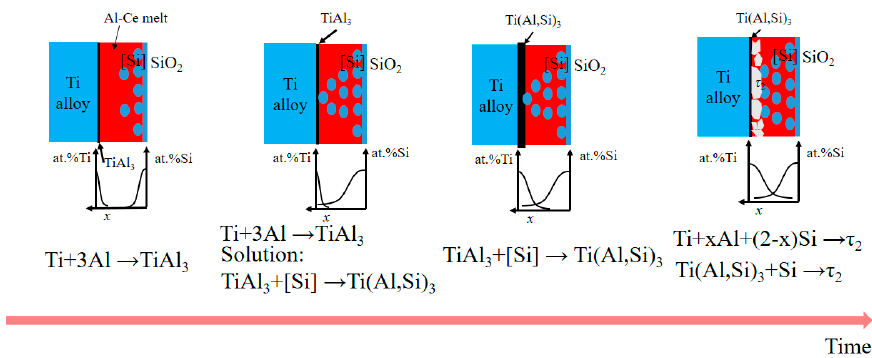
Figure 4. Schematic diagram of the growth mechanism of cerium-added coating.